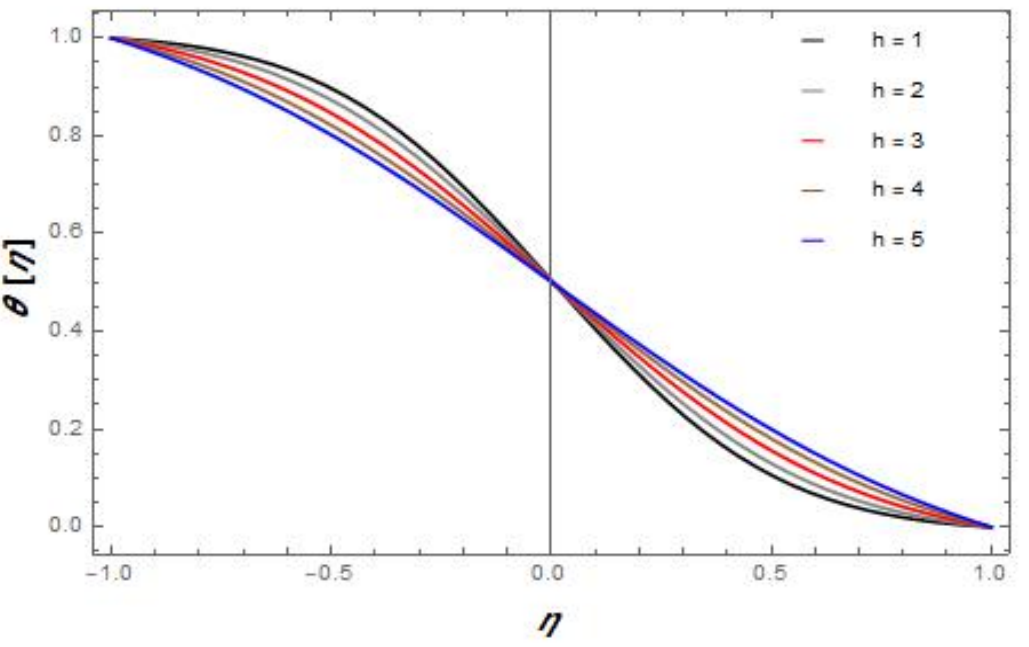
Figure 3. Effect of activation energy on mass concentration.